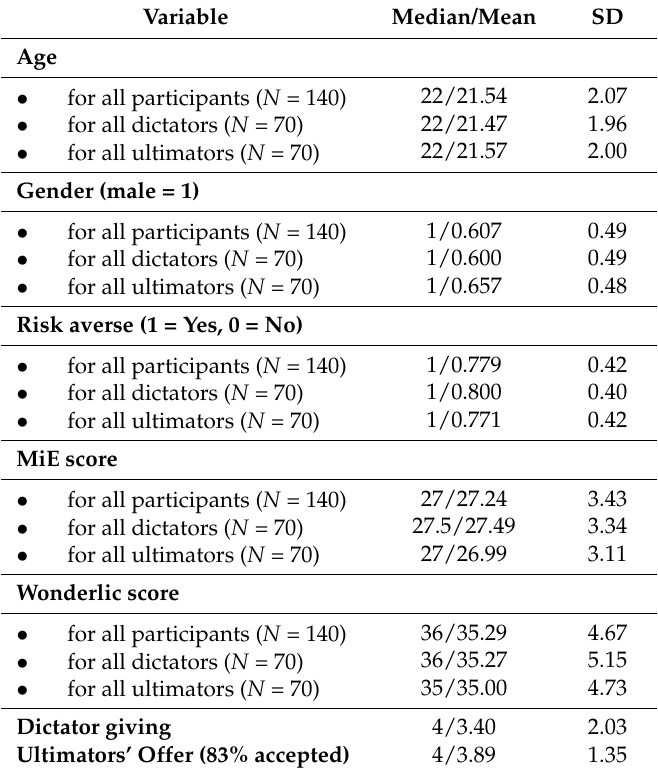
Table 1. Descriptive statistics (Mean and